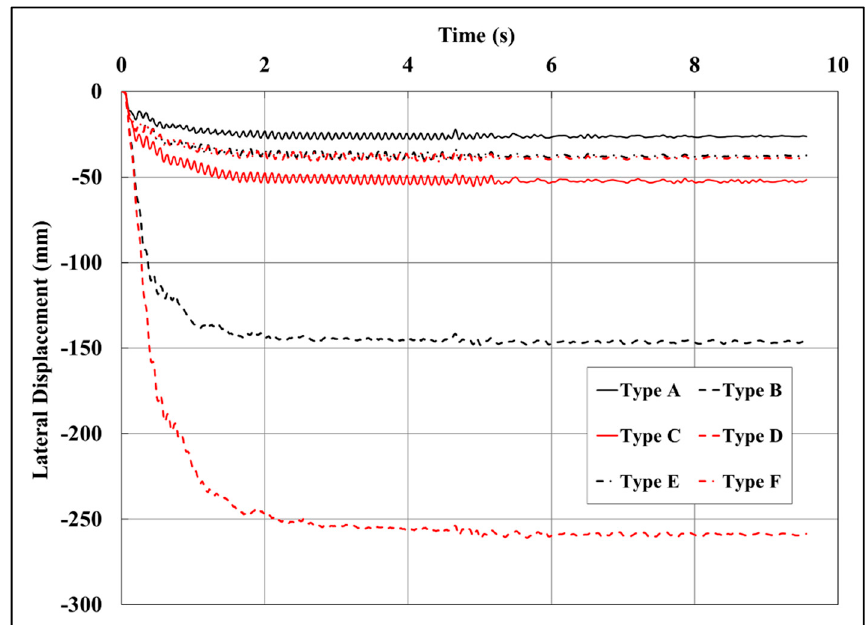
Figure 7. Lateral displacement at the top for each type: D-F2-B2-10 (type A), S-F1-10 (type B), D-F4-B4-5 (type C), S-F2-5 (type D), D-F4-B2-7.5 (type E), and D-F2-B4-7.5 (type F).